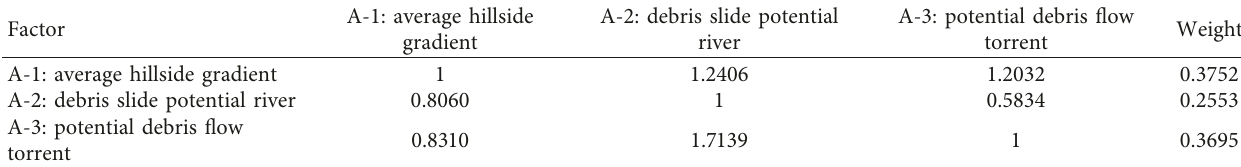
Table 6: Relative importance of factors for “A: potential.”